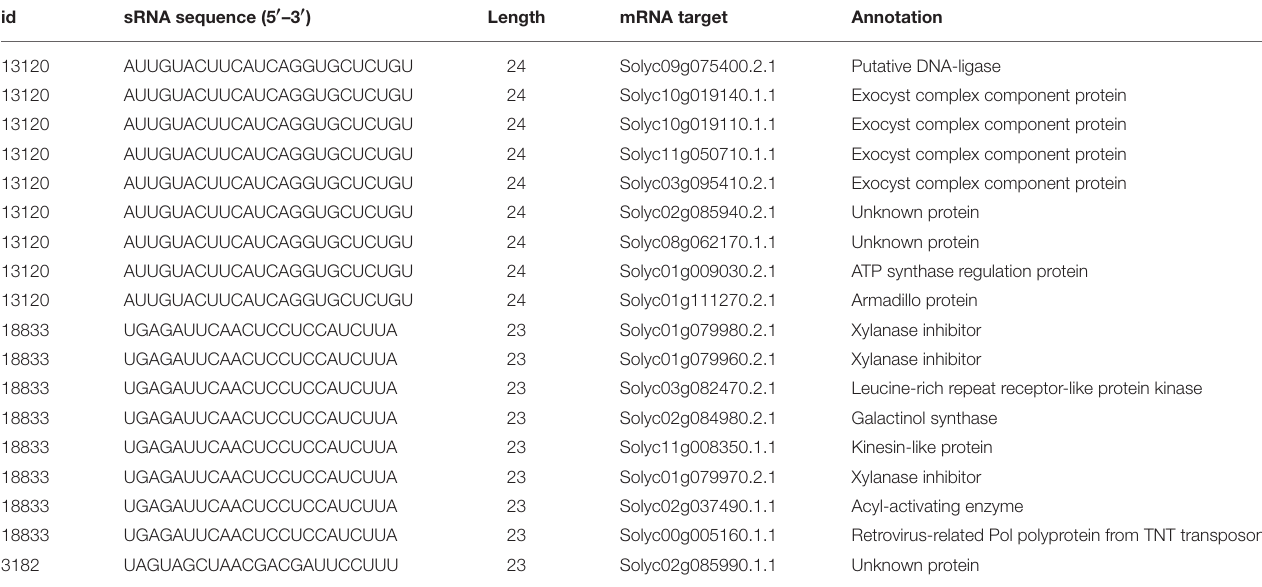
TABLE 2 | List of predicted mRNA targets from the selected whitefly small RNA found in tomato tissues. id sRNA sequence (5 ′ –3 ′